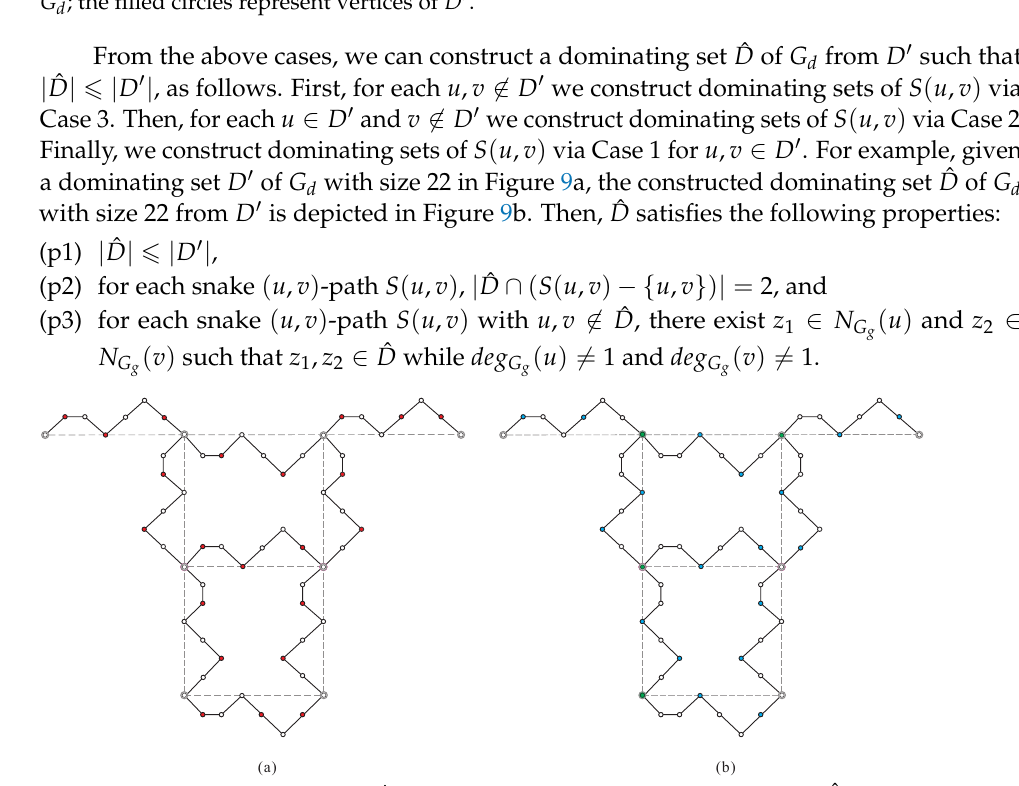
Figure 9. ( a ) The dominating set D (cid:48) of G d with size 22, and ( b ) a dominating set ˆ D of G d with size 22 ( (cid:54) | D (cid:48) | ) obtained from D (cid:48) . Solid lines indicate the edges of G d , double circles represent the vertices of G g , and filled circles indicate the vertices in a dominating set of G d